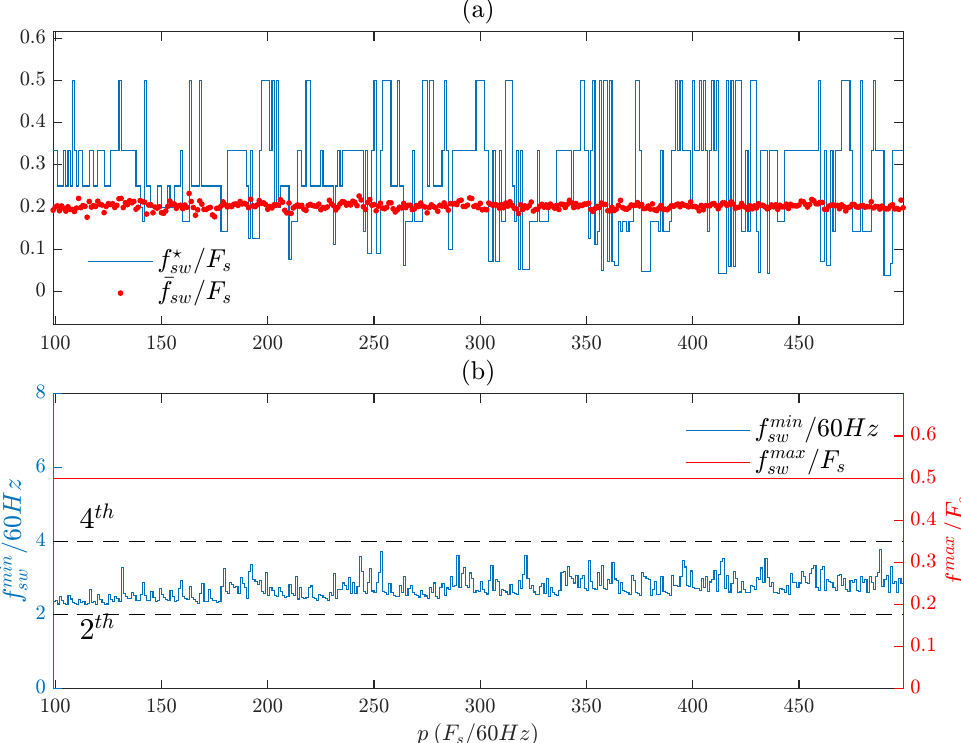
Figure 11. Sampling frequency effect in FCS-MPC using the cost function (11): ( a ) f (cid:63) sw and ¯ f sw ; ( b ) f max sw and f min sw .